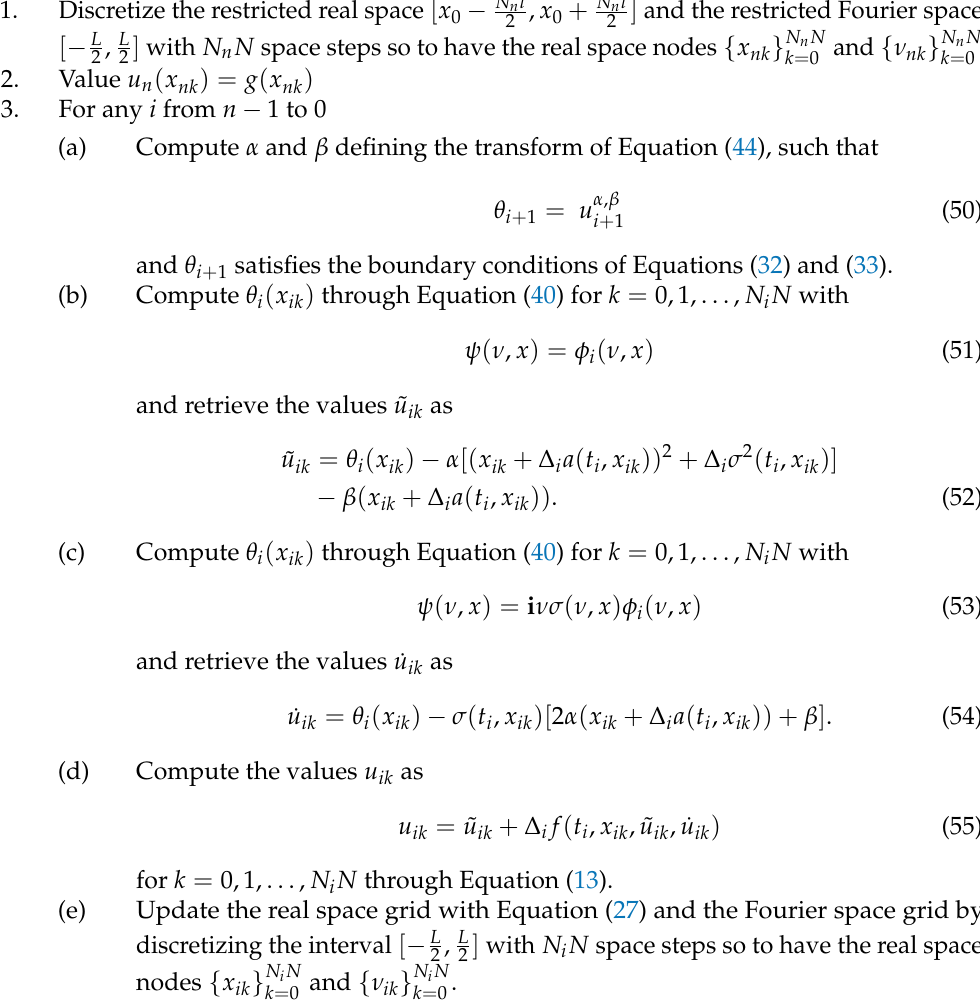
Algorithm 1 details the numerical procedure on the space grid and produces numerical